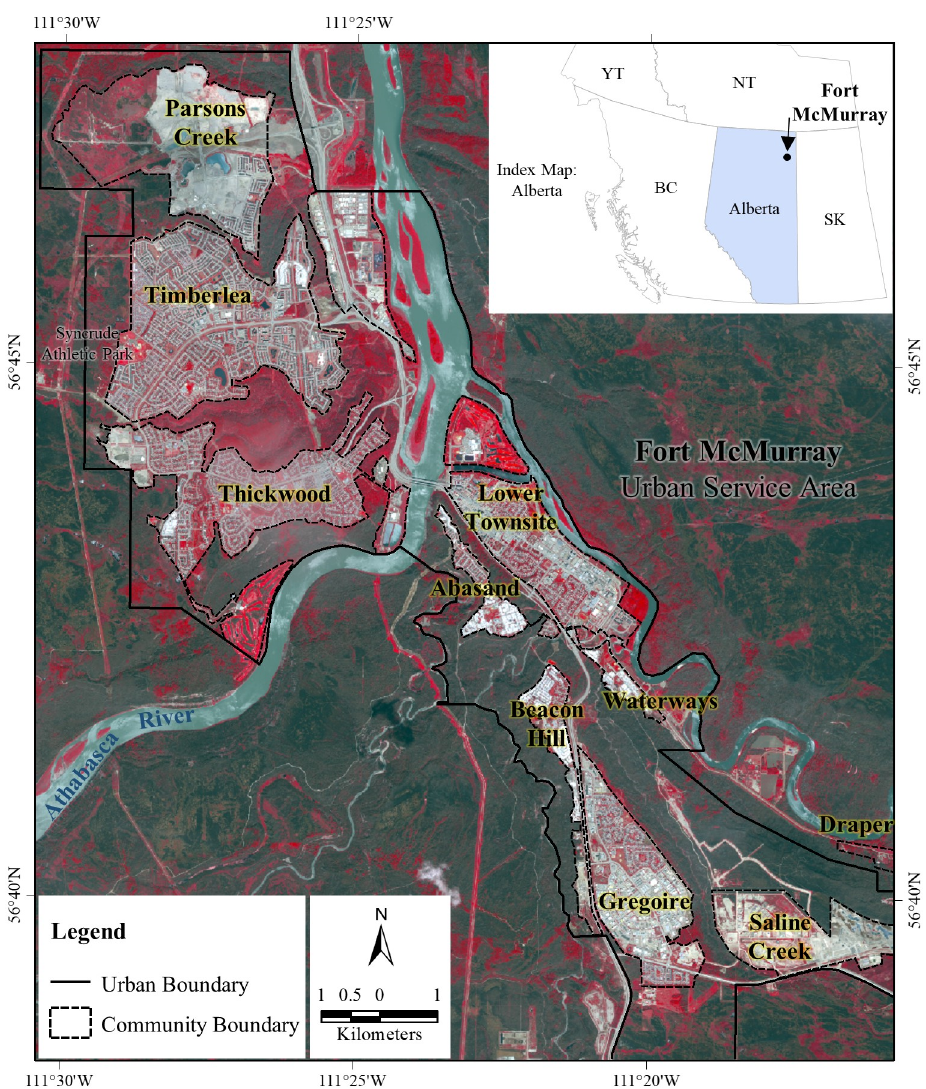
Figure 1. The study area is the communities of Fort McMurray urban service area in RMWB. Here, the service area and community boundaries are demarcated as solid and dotted lines, respectively over a WorldView-2 satellite image acquired on 6 June 2016. Dark greenish to gray colors in the image represent burned vegetation, and bright red to reddish colors as healthy vegetation. (adopted from Ahmed et al. [1] licensed under CC BY 4.0).